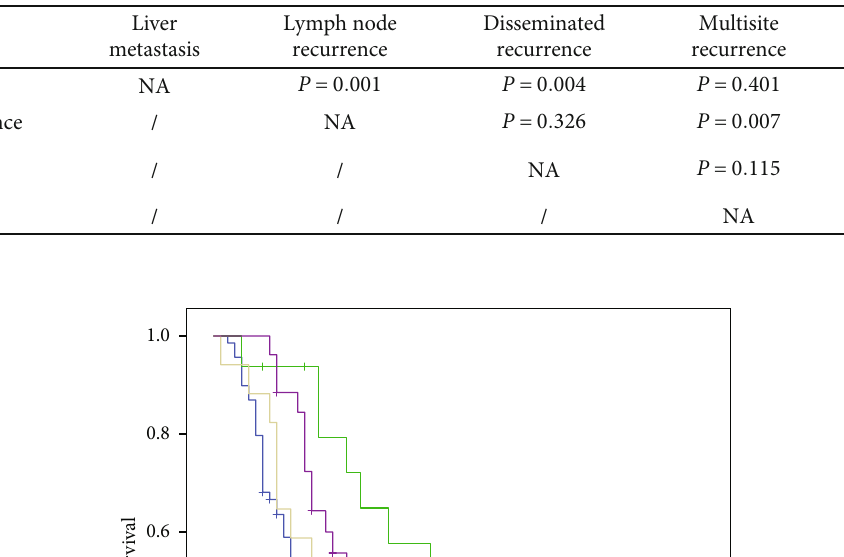
Table 6: Comparison of the prognosis of patients with di ff erent recurrence patterns.